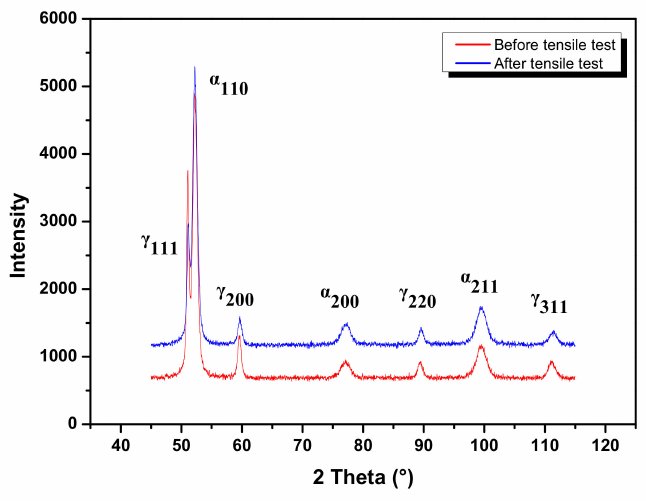
Figure 9. The X-ray diffraction (XRD) patterns for the carburized case of the specimens austenitized at 900 ◦ C before and after the tensile